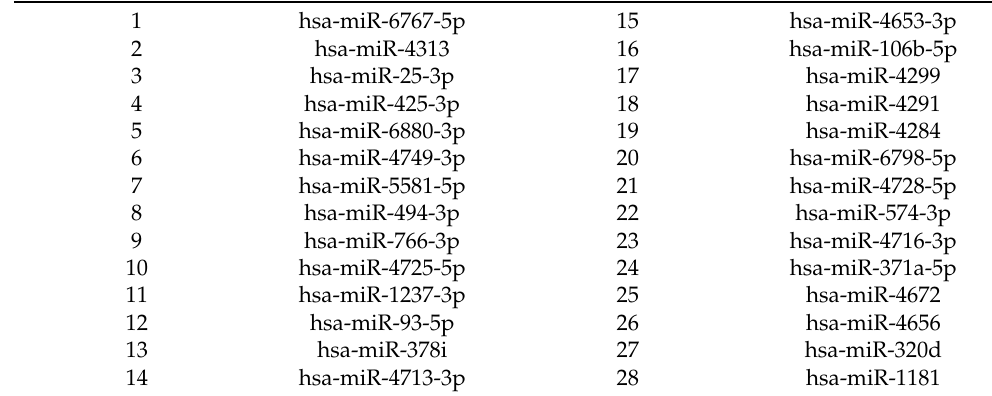
Table 2. List of the 28 exosomal miRNAs significantly overexpressed in all ovarian cancer cell lines.